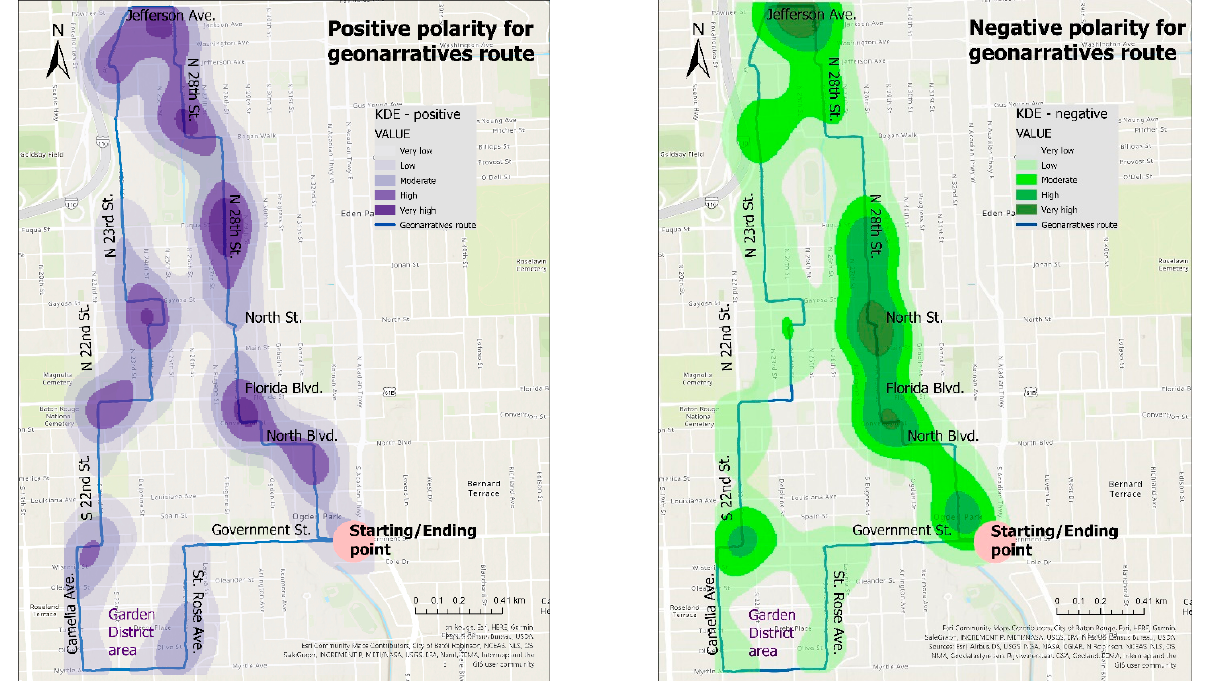
Figure 10. Example of mapping a portion of a geonarrative’s transcript applying Wordmapper (Ajayakumar, Curtis et al. 2019).